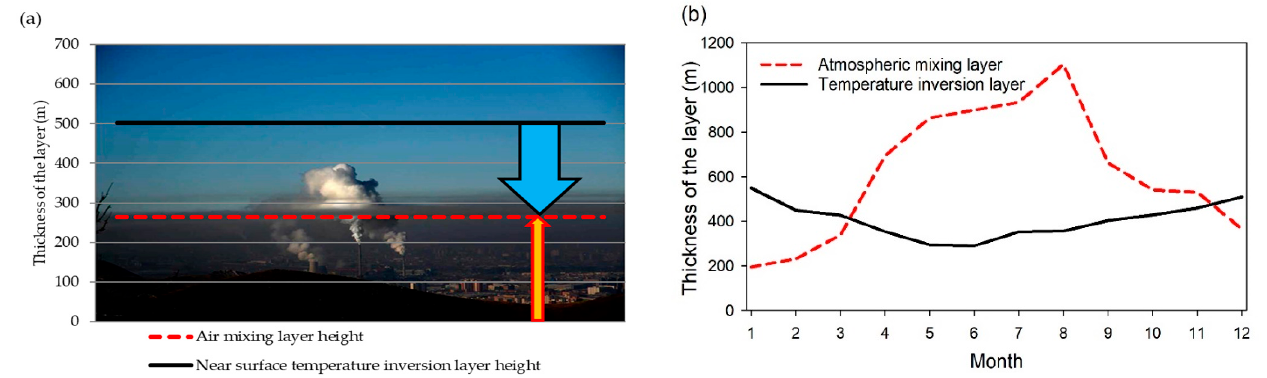
Figure 12. Winter ( a ) and seasonal ( b ) variations in MLH and temperature inversion layer thickness according to morning radiosonde data.